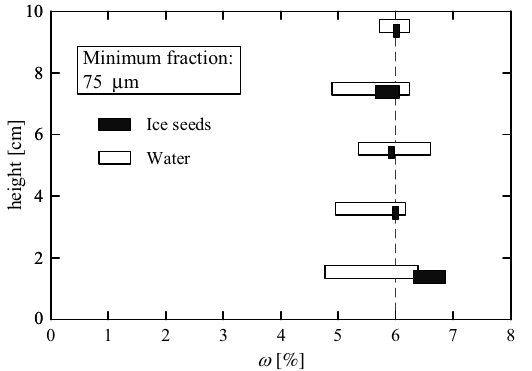
Figure 8. Horizontal distribution of water content at different heights in a soil sample which was initially mixed with a global amount of ω = 6%